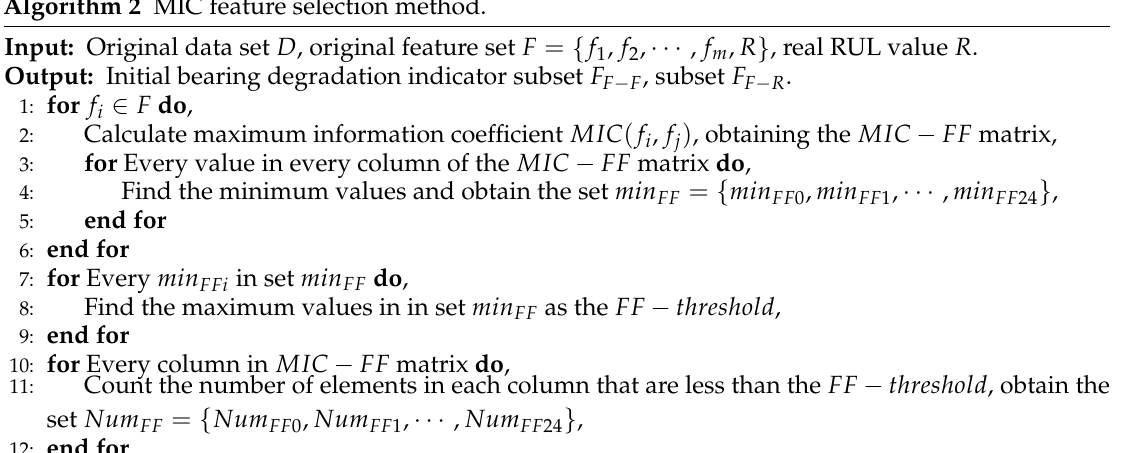
Algorithm 2 MIC feature selection